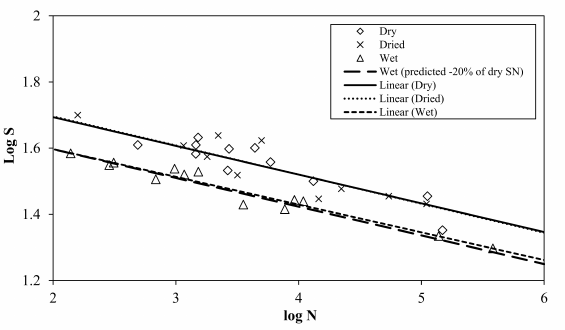
Figure 6: S-N curves of initial (dry), saturated and dried epoxy speci- mens in log-log